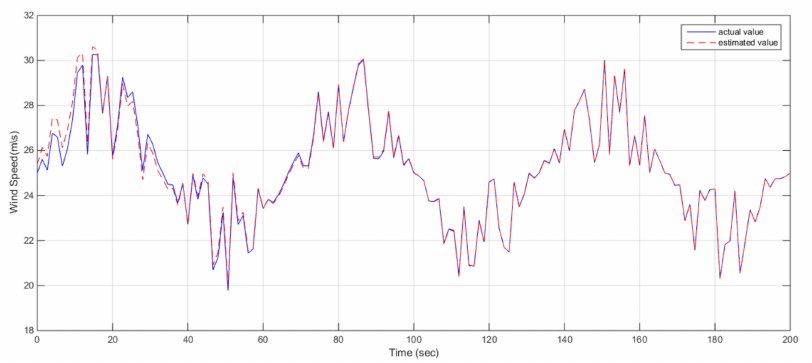
Figure 6. Wind speed disturbances and its estimation.